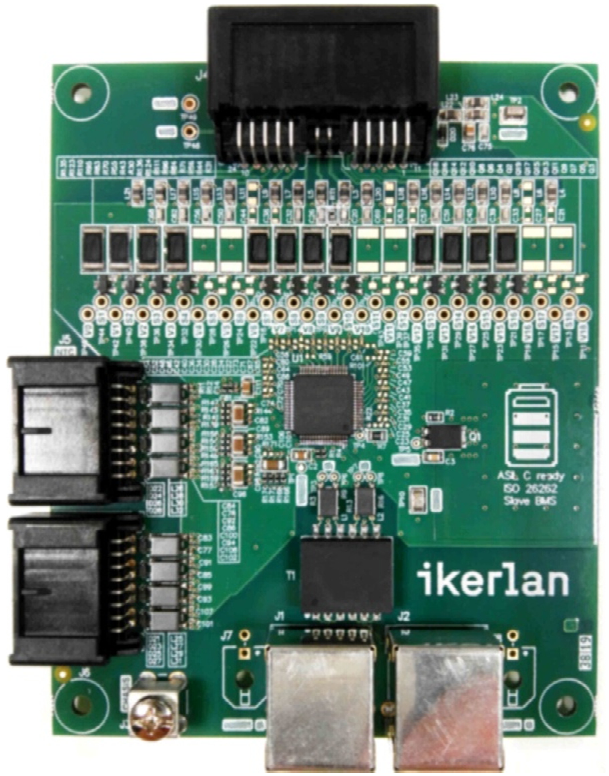
Figure 5. Developed enhanced battery management system slave prototype complying with func- tional safety ASIL C requirements. tional safety ASIL C